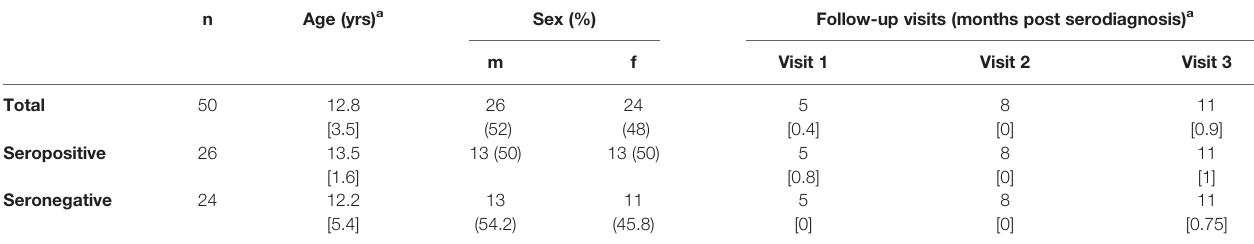
TABLE 1 | Characteristics of study cohorts.